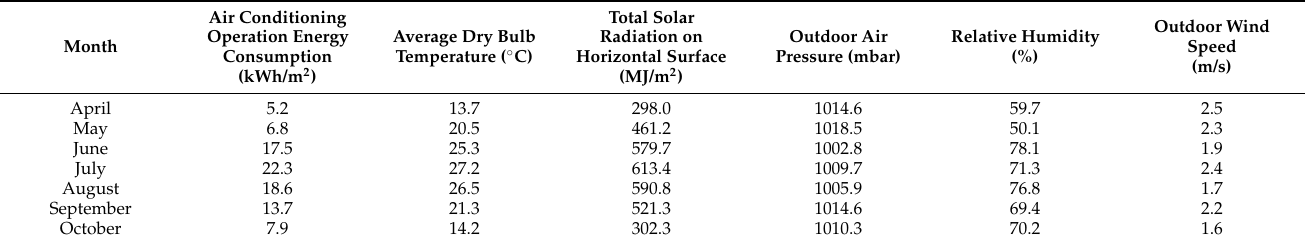
Table 7. Building energy consumption and influencing factors in existing service